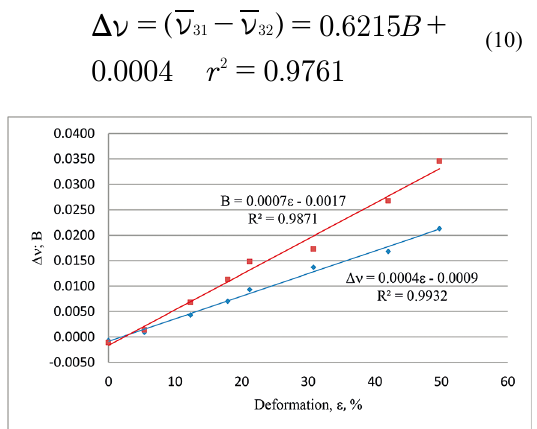
Figure 3. Effect of deformation on birefringence B and on the difference between Poisson’s ratios ∆ ν = ( ν ̅